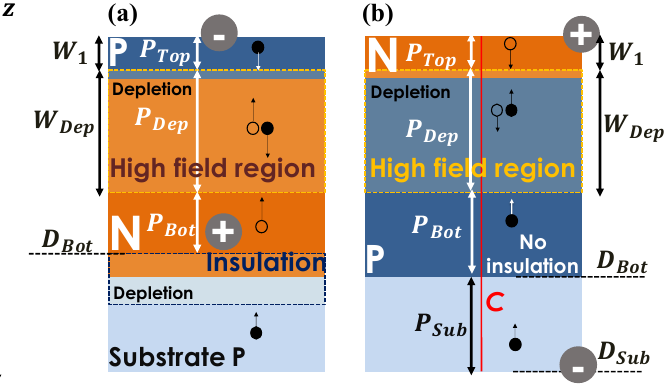
Figure 2. Typical SPAD cross-sections. ( a ) A SPAD with complete insulation between the high field region and ( b ) a SPAD without